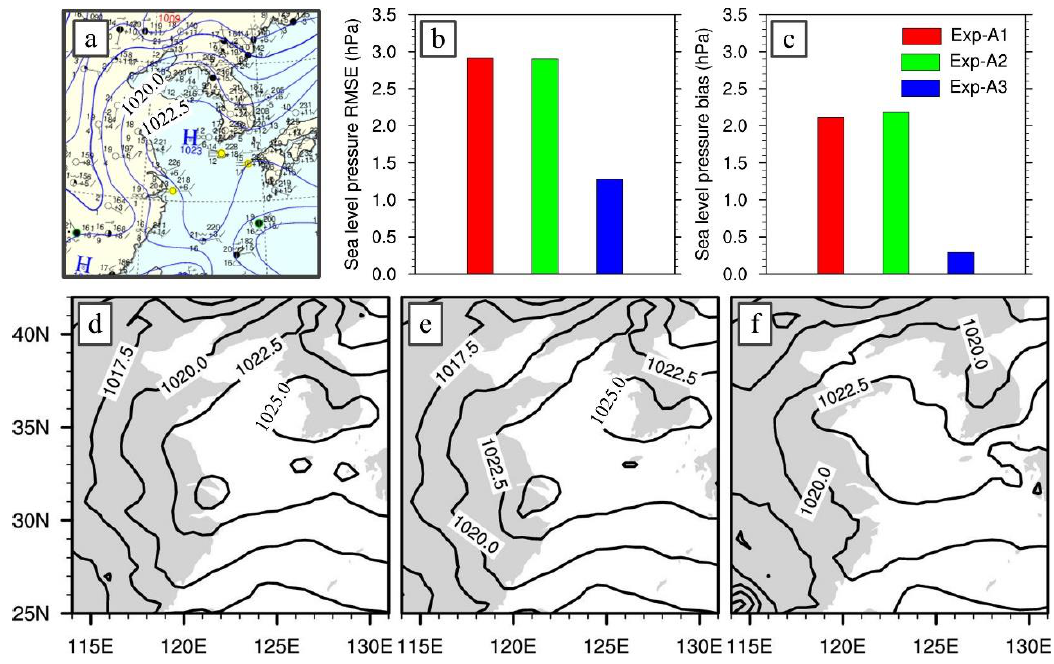
Figure 7. Evaluation result of sea level pressure (SLP) in the initial analysis for the Case C-09. Top panels respectively show ( a ) KMA surface synoptic chart, ( b ) RMSE, and ( c ) bias of SLP by using surface measurements. Bottom panels illustrate SLP of ( d ) Exp-A1, ( e ) Exp-A2, and ( f ) Exp-A3, respectively.